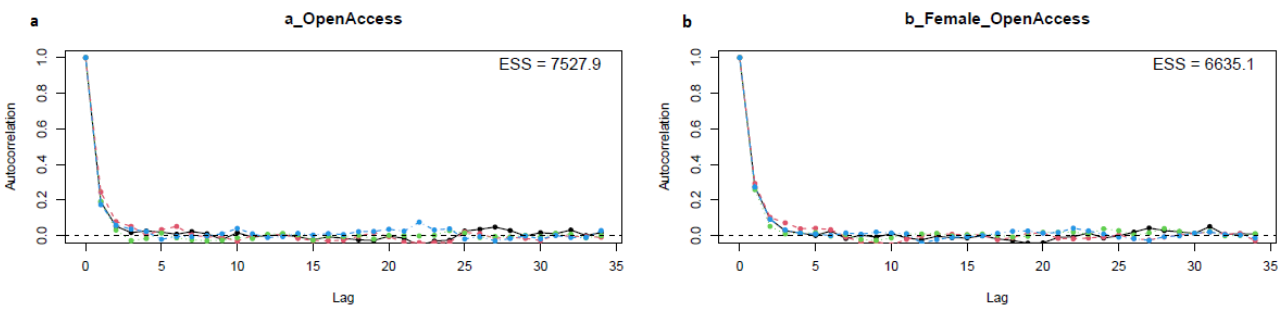
Figure A1. Gelman plots of parameters: ( a ) Constant; ( b ) Female; ( c ) Female × FirstFemale; ( d ) Female × SoloFemale; ( e ) Female × AllFemale.